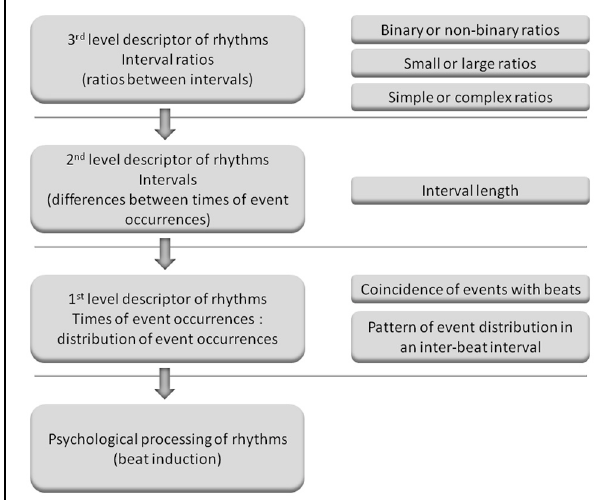
FIGURE 2 | Illustration of the three levels of descriptors of rhythms. (Left) The possible relationships between different levels of descriptors of rhythms and psychological processing of rhythms. When listening to musical rhythms, the feeling of a beat is induced and beat induction is considered as psychological processing of rhythms. Musical rhythm refers to the organization of events in time in a hierarchical metrical structure, and therefore times of event occurrences may be most related to beat induction and are referred to as the first level descriptor. Intervals are derived from times of event occurrences and interval ratios are derived from intervals. Therefore, intervals and interval ratios are referred to as the second and third level descriptors, respectively. The third level descriptor may influence beat induction by the second level descriptor, and the second level descriptor may influence beat induction by the first level descriptor (as indicated by arrows). (Right) Measures for different levels of descriptors. For example, interval ratios can be examined in terms of magnitude, complexity, or type (binary or non-binary). Times of event occurrences can be represented as the distribution of event occurrences (event distribution), i.e., the numbers of events occurrences at different positions within a beat interval. The distribution of event occurrences can be measured by the coincidence of events with beats or the pattern of event distribution in a beat interval (event distribution pattern, as shown in the present study). (The concept of the three levels of descriptors was proposed in a personal communication with Bruno Repp. This figure is provided here to illustrate the logic behind the present study: after observing the binary advantage for serial interval ratios, further examining factors more related to psychological processing of rhythms. We have no intention to define a specific frame of the three levels of descriptors, e.g., influencing factors of rhythm processing can be classified into only three levels, or a given factor has to belongs to a given